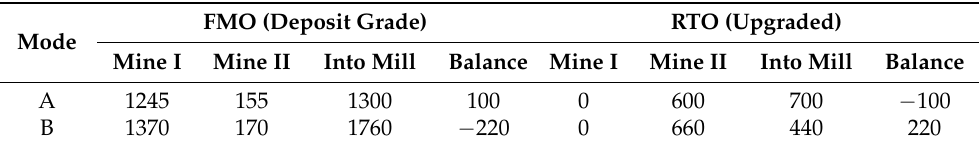
Table 2. Summary of the overall mass balance of FMO and RTO expected at the processing plant (expressed in t/d) under the available operational modes, ignoring geological